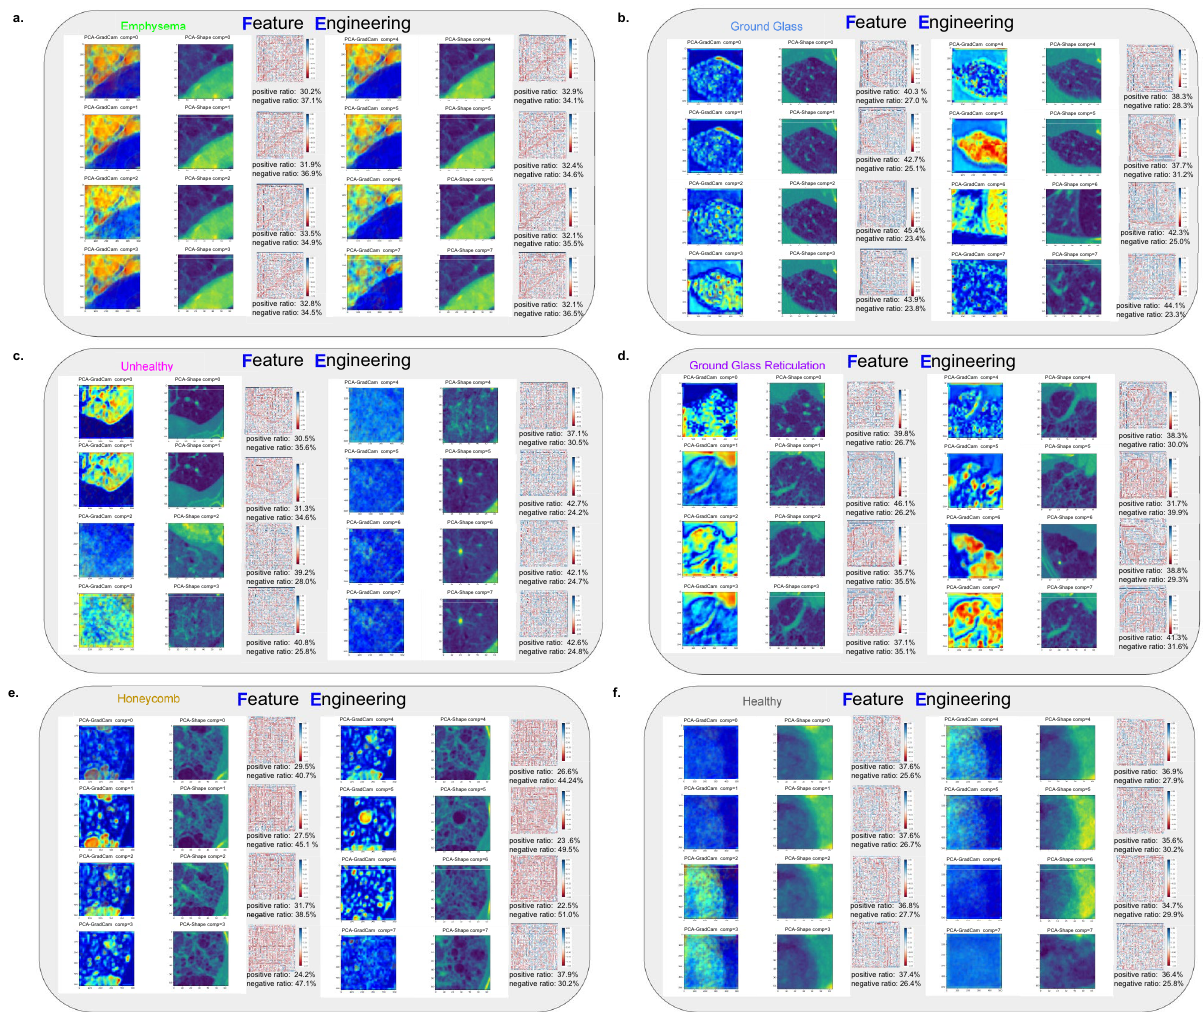
Figure 7. The generalized combined explainable technique of local explanable and interpretable reduced dimensionality techniques (PCA-GradCam, PCA-Shape). ( a – f ) The PCA of the patch images (PCA-Shape) and GradCam results (PCA-GradCam) of each class for the eight components analysis. The correlation coefficient of each component’s PCA-Shape and PCA-GradCam with the negative and positive ratio is presented. For each class from left to right, top to bottom the eight components results of the PCA analysis. The results are based on the DenRes-131 and 32 × 32 × 3 patch size for the multi-classification